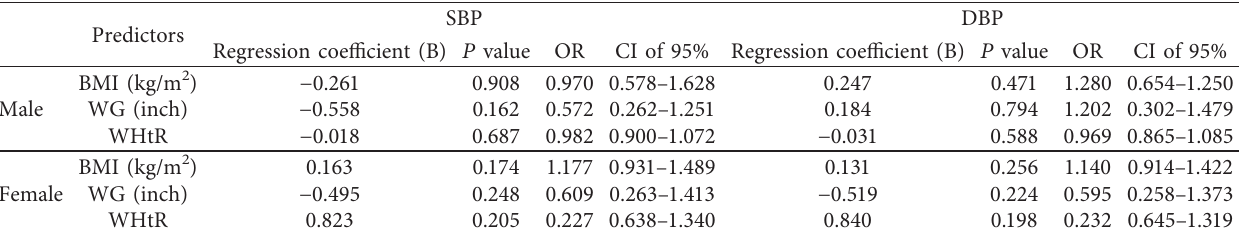
Table 4: Regression analysis summary for the trio-anthropometric predictors of SBP and DBP in male and female rural dwellers of Afikpo community, Ebonyi State, Nigeria.